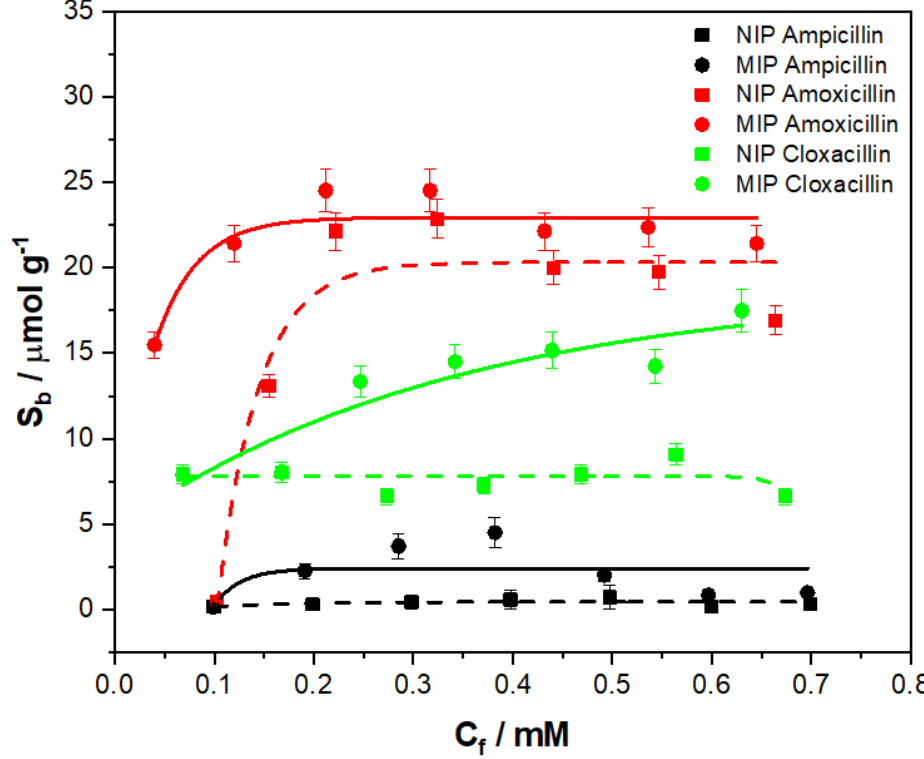
Figure 9. Binding isotherm for the interaction of ampicillin (black squares/circles), cloxacillin (green squares/circles), and amoxicillin (red squares/circles) with MIP 205, where the interactions of both MIP (circles) and NIP (squares) are displayed.